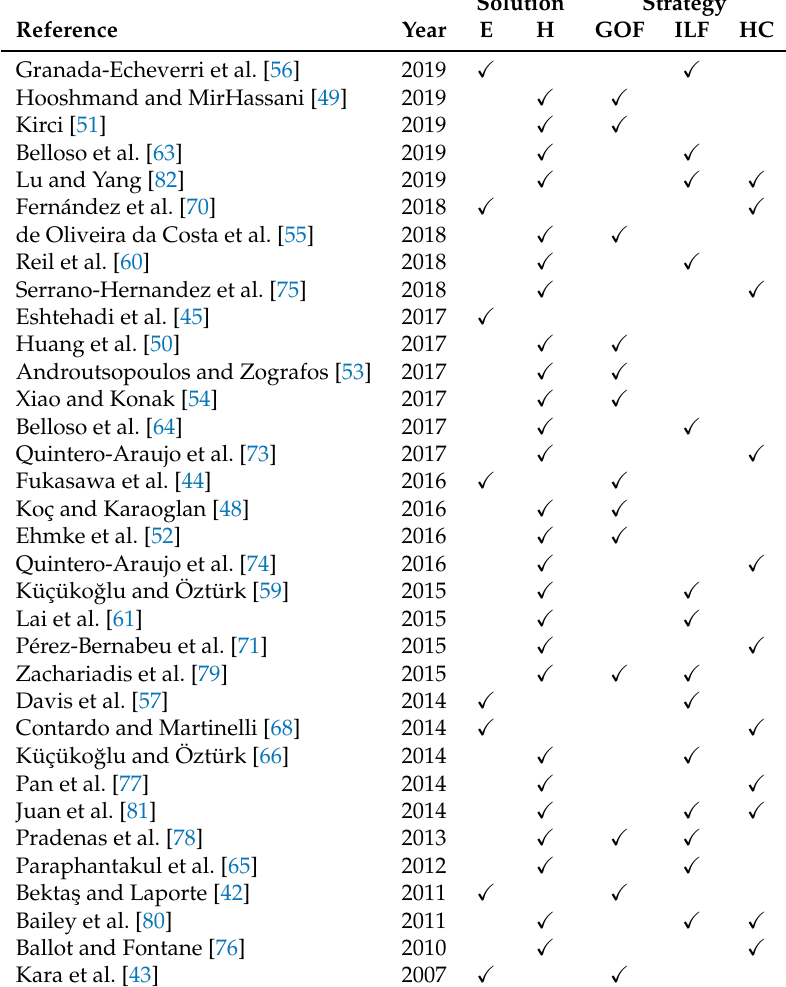
Table 4. Relevant literature in energy-related road freight transportation optimization based on solution approach (E, Exact; H, Heuristic) and strategy adopted (GOF, Green objective function; ILF, Improving load factors; HC, Horizontal